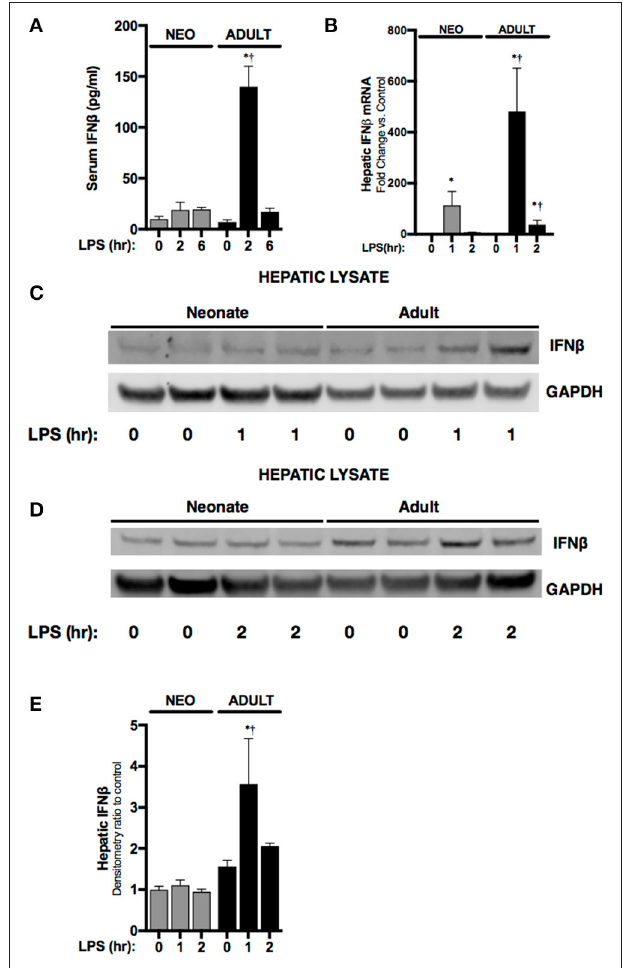
FIGURE 1 | Neonates demonstrate attenuated LPS-induced hepatic IFN β expression. (A) Serum levels of IFN β in neonatal or adult mice following LPS exposure (0–6h, 5 mg/kg). * p < 0.05 vs. control; † p < 0.05 vs. LPS-exposed neonate. Values shown as means ± SEM; n = 3–4/timepoint. (B) Fold-increase in gene expression of IFN β in neonatal and adult liver following LPS exposure (0–2h, 5 mg/kg). * p < 0.05 vs. control; † p < 0.05 vs. LPS-exposed neonate. Values shown as means ± SEM; n = 5–6/timepoint. (C,D) Representative Western blots showing IFN β protein in neonatal